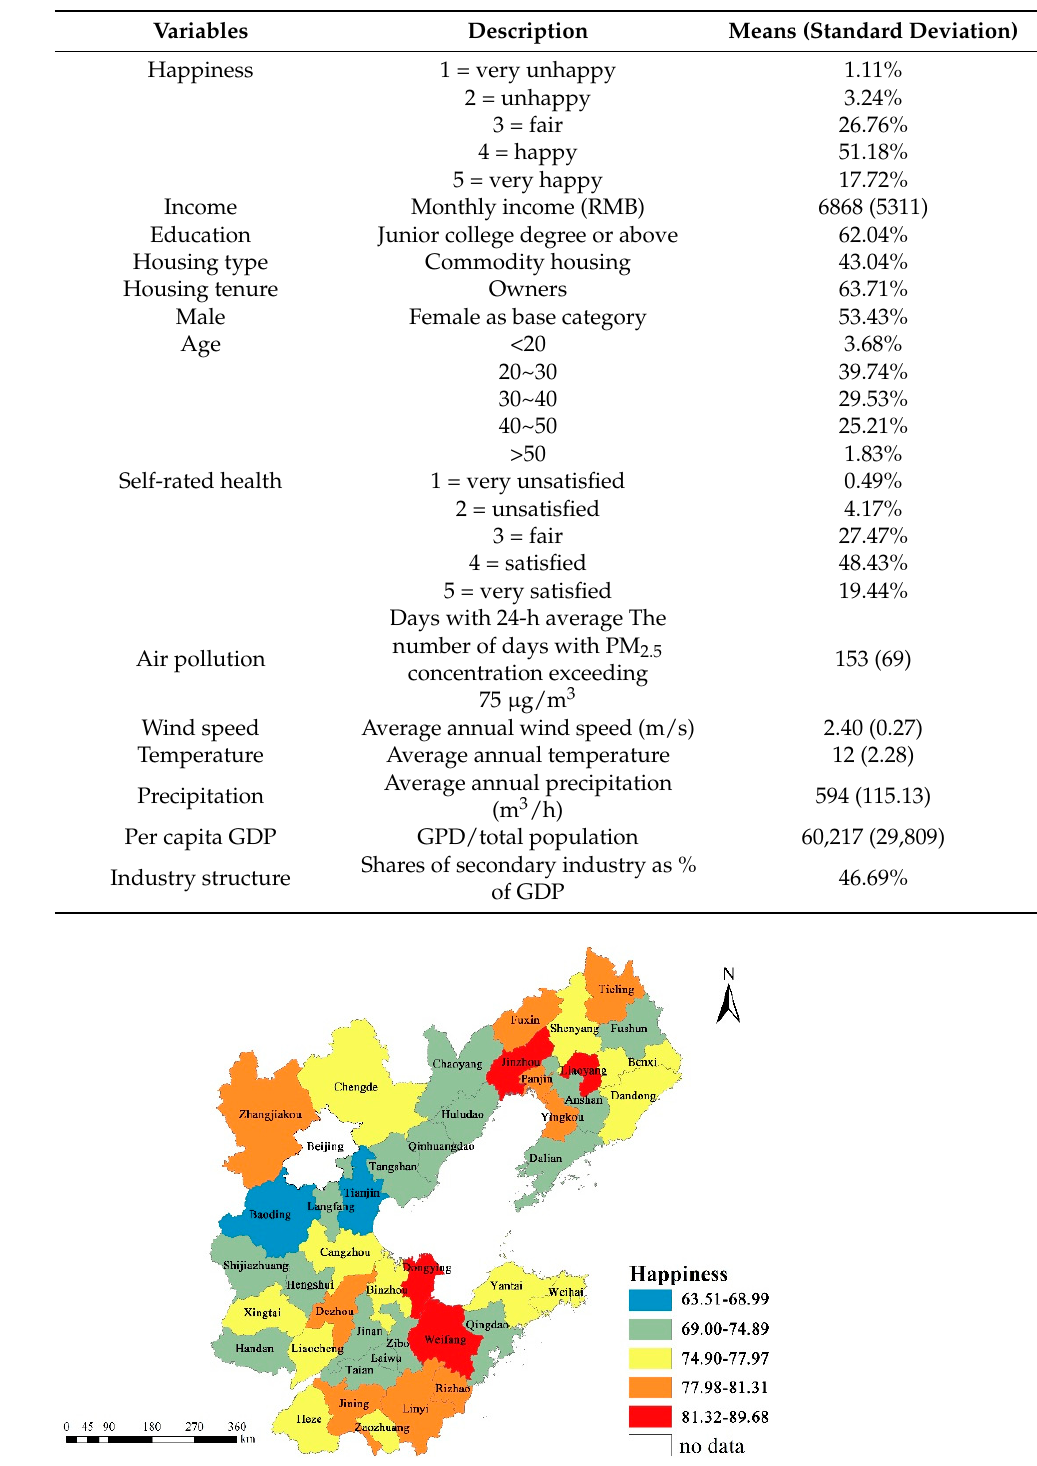
Figure 2. Spatial distribution of happiness in the Bohai Rim area.